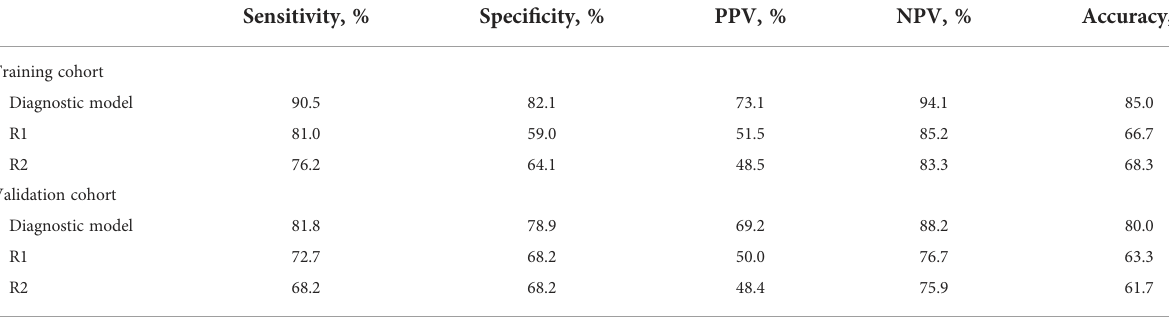
TABLE 4 Comparison between subjective evaluation and diagnostic model diagnosis.